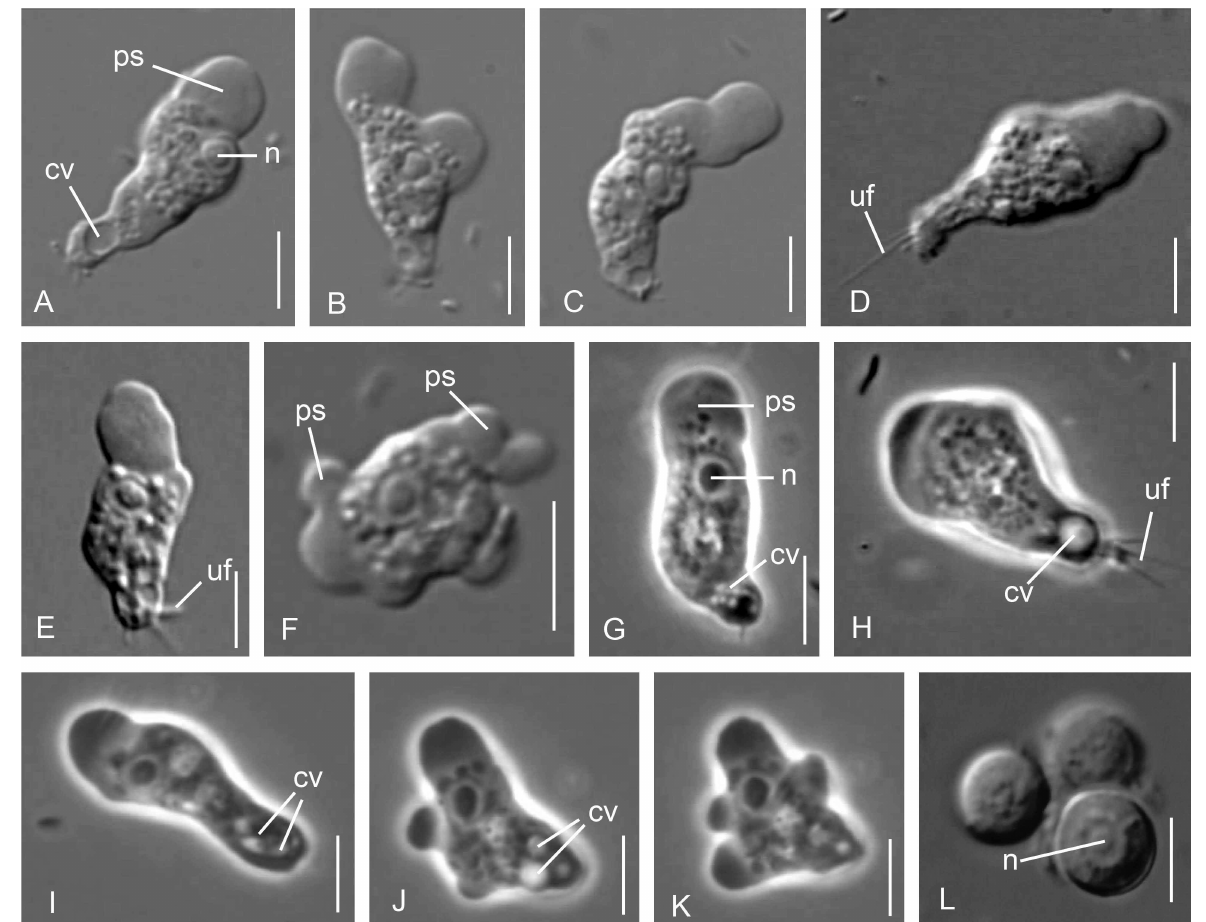
Figure 1. Light microscopy of cells ( A – K ) and cysts ( L ) of P. stagnalis . Abbreviations: cv—contractile vacuole, n-nucleus, ps—pseudopodium, uf—uroidal filaments. Scale bars: 5 µ